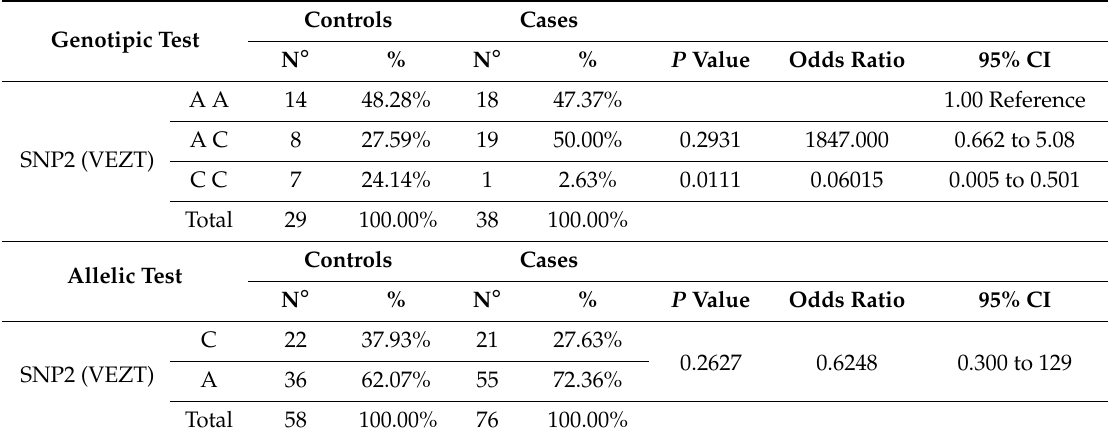
Figure 1. Distribution of AA, GA and GG genotypes obtained for the rs11031006 polymorphism (FSHB). Table 6. Genotypic and allelic frequencies of rs10859871